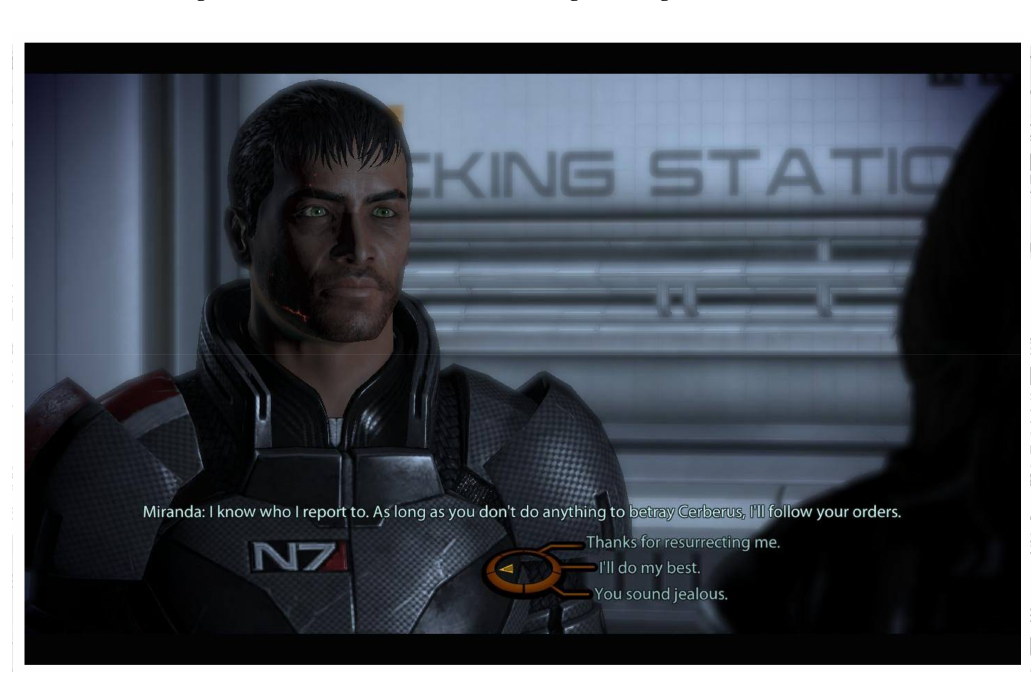
Figure 2. Dialog in Mass Effect 2 16